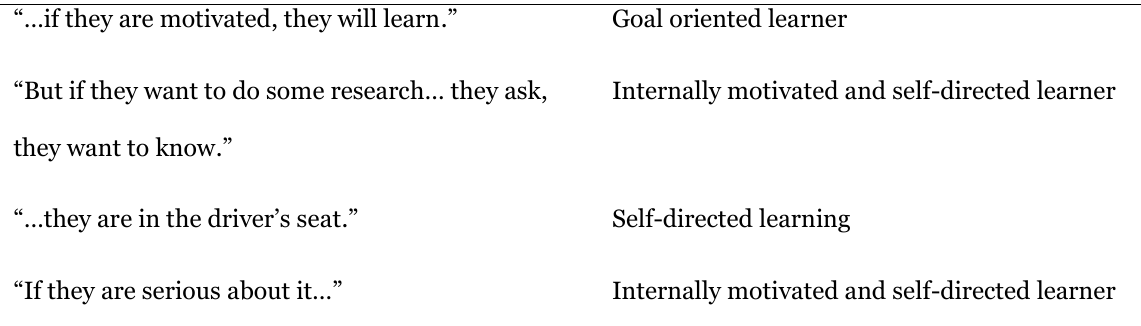
Data Analysis Example: User Learning Skills Text